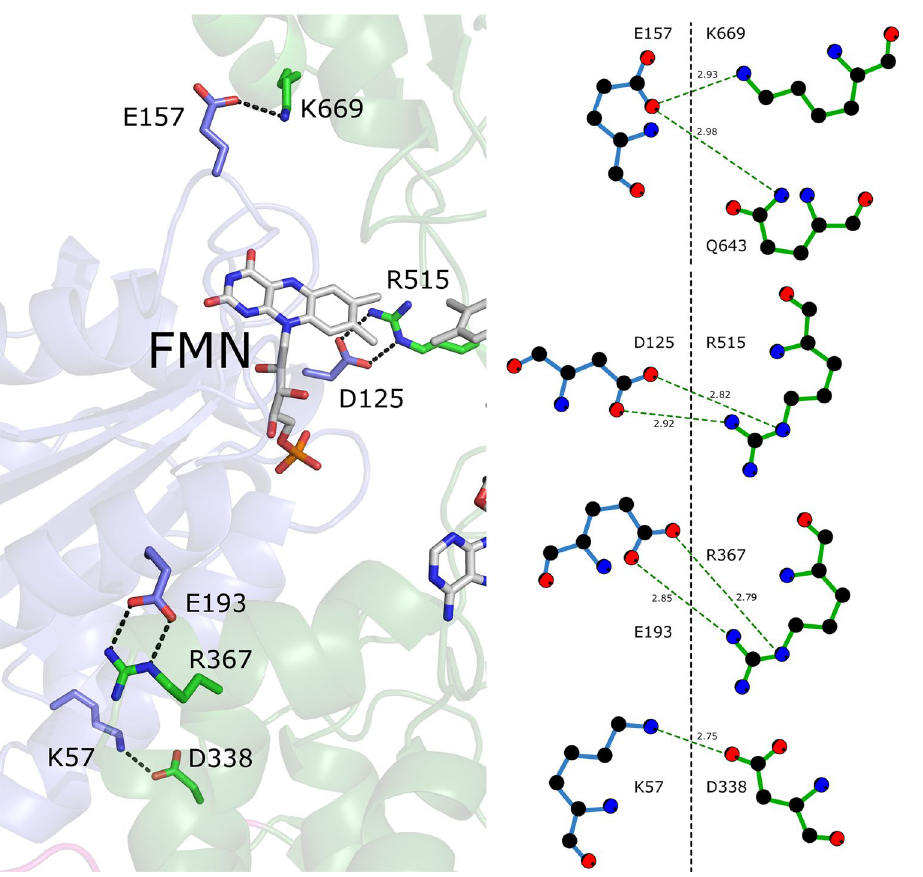
Figure 5. Salt bridges between residues in the interfaces of the FMN and FAD domains of Ct